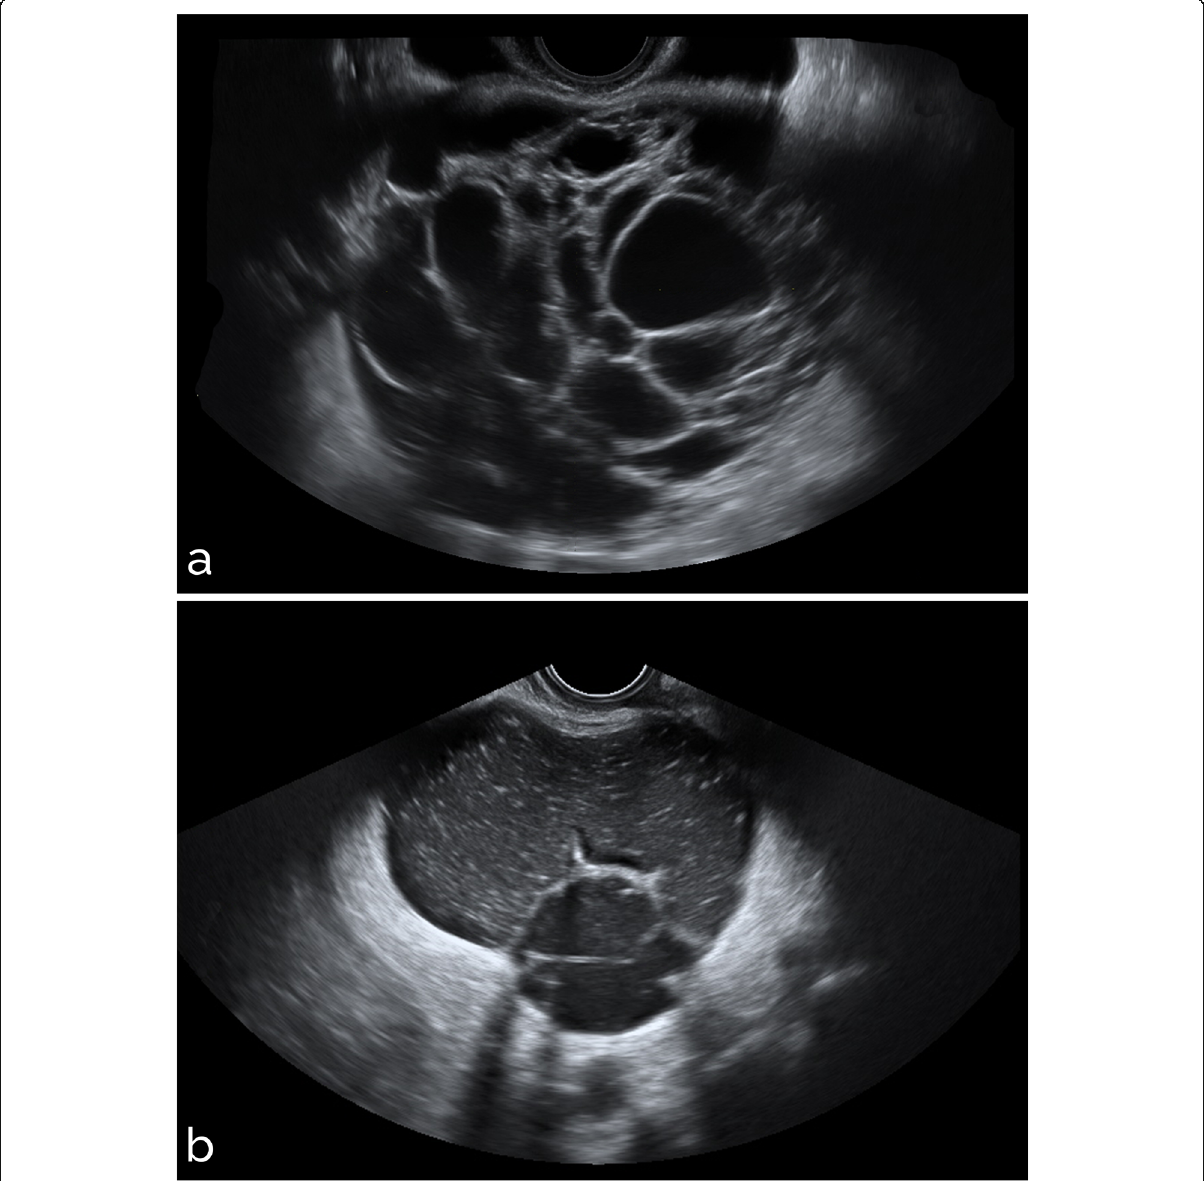
Fig. 8 Transvaginal ultrasound of cystic ovarian masses: ( a ) mucinous ovarian cancer on histological examination (medium-high risk), ( b ) mucinous cystoadenoma on histological examination (very low